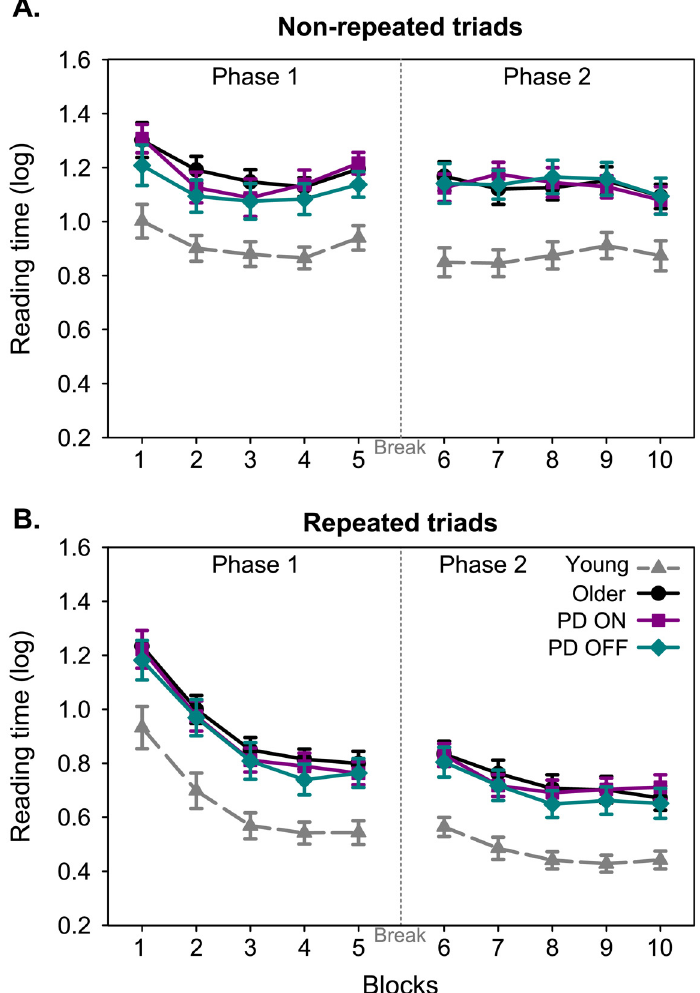
Fig 2. Mean reading times necessary for the participants to read the non-repeated triads (A) and the repeated triads (B) of mirrored-inverted words. The mean reading time (in seconds, log-transformed) was plotted as a function of the experimental blocks (1 to 10) for the young adults (grey), the older adults (black), the PD ON their medication (purple) and the PD OFF their medication (cyan). The blocks 6 to 10 were performed following a 50-minutes break represented by the dashed vertical line. Error bars are standard-error of the mean.